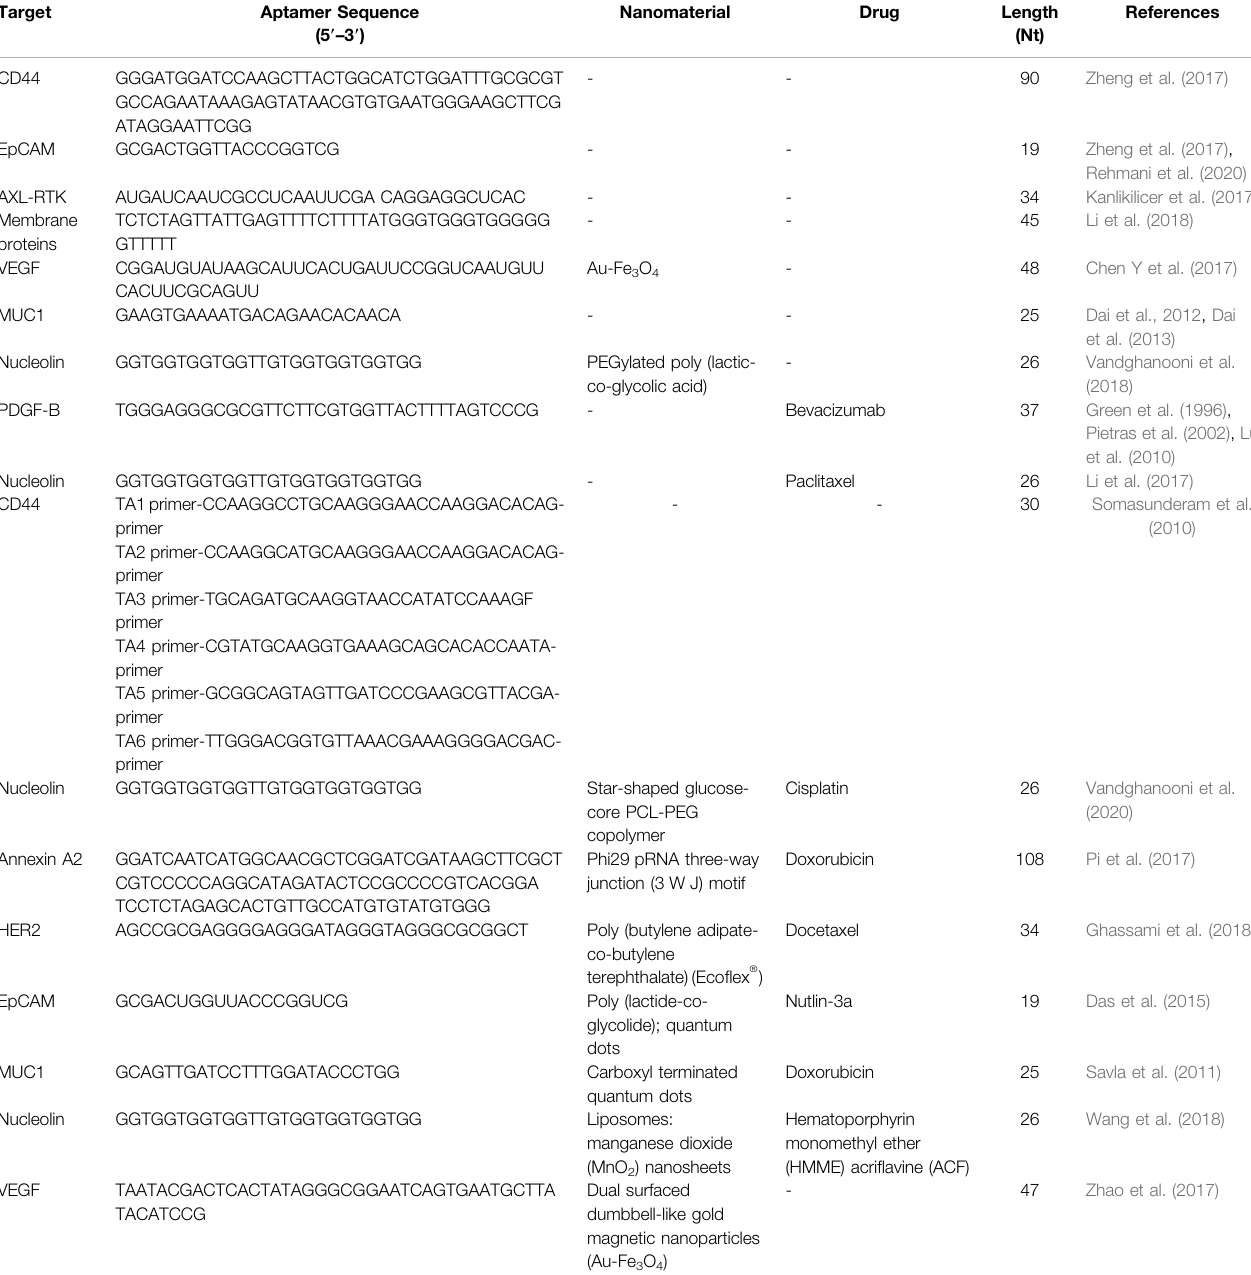
TABLE 2 | Aptamer nanomaterials for treatment of ovarian cancer.